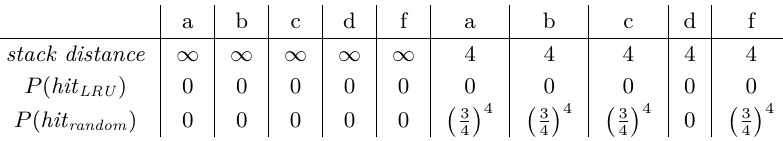
Table 1 Comparison of random and LRU hit probabilities for all accesses in the sequence a, b, c, d, f, a, b, c, d, f when reuse and stack distances of all accesses are known (same information) in a cache with associativity